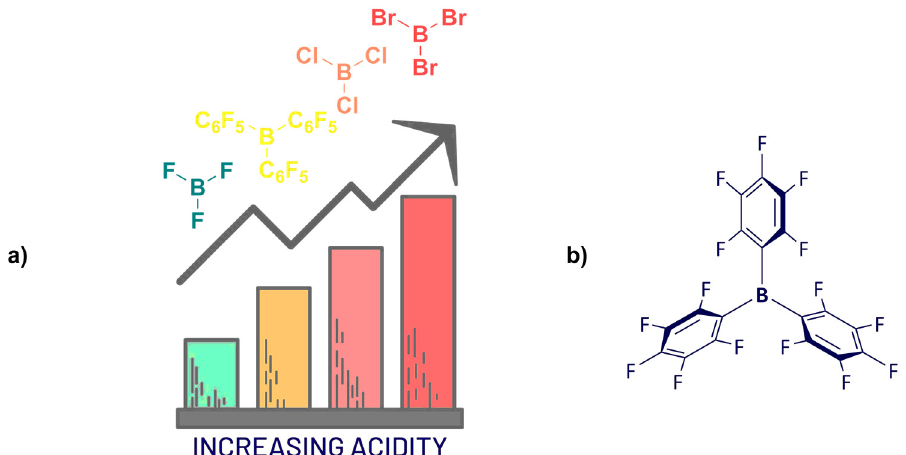
Figure 1. ( a ) Visual representation of the scale of increasing acidity of different boron-based Lewis acids; ( b ) Tris(pentafluorophenyl)-borane (BCF).